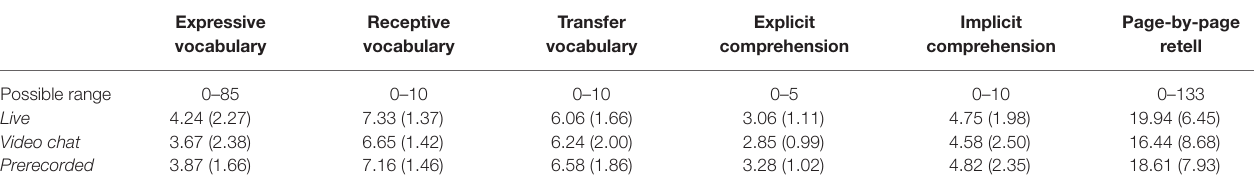
TABLE 5 | Descriptive results for vocabulary and comprehension measures by